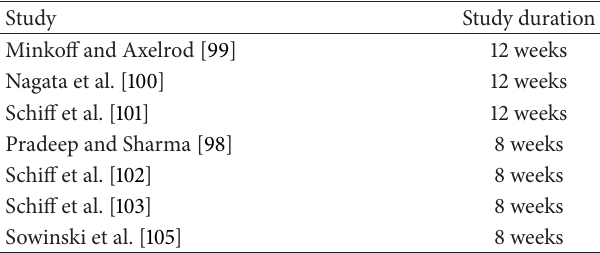
Table 5: Study duration of included studies.